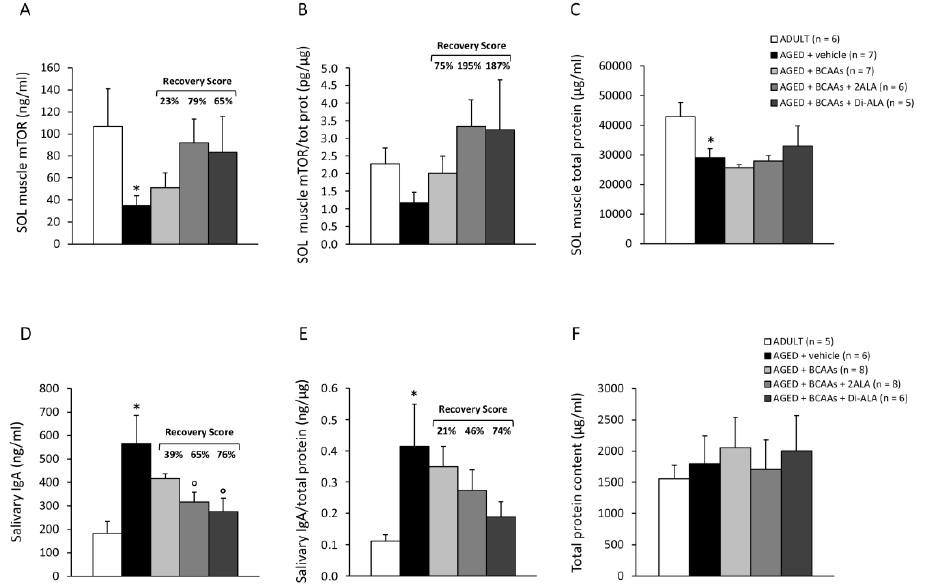
Figure 7. mTOR protein levels, measured by ELISA in SOL muscle from ADULT mice and AGED mice treated with vehicle, BCAAs, BCAAs + 2ALA or BCAAs + Di-ALA, expressed as absolute ( A ; ng/mL) or normalized to total protein ( B ; pg/µg). Total protein content was measured in all mice groups via a Bradford assay, and the results (µg/mL) are shown in ( C ). All values are expressed as mean ± SEM for the number of mice indicated in brackets. For A and C, a statistically significant difference was found via an unpaired Student’s t-test for AGED + vehicle vs. ADULT mice ( p < 0.05). No statistically significant differences were found among AGED groups via a one-way ANOVA followed by Dunnett’s post hoc test for any parameter. The recovery scores towards ADULT values, calculated for each treated group, are indicated above the bars. ( D , E ) show immunoglobulin A (IgA) levels measured in saliva samples collected from all mice, expressed as absolute (ng/mL) or normalized to salivary total protein (ng/µg). Total protein content was measured via a Bradford assay, and the results (µg/mL) are shown in ( F ). Values are expressed as mean ± SEM for the number of mice indicated in brackets. For ( D , E ), a statistically significant difference was found via an unpaired Student’s t -test for AGED + vehicle vs. ADULT mice (*; 0.02 < p < 0.05). Only for absolute IgA values, a statistically significant difference among AGED mice groups was found via a one-way ANOVA (F = 3.87, p < 0.03). Dunnett’s post hoc test is as follows: ° vs. AGED + vehicle ( p < 0.02). Recovery scores are indicated above the bars.